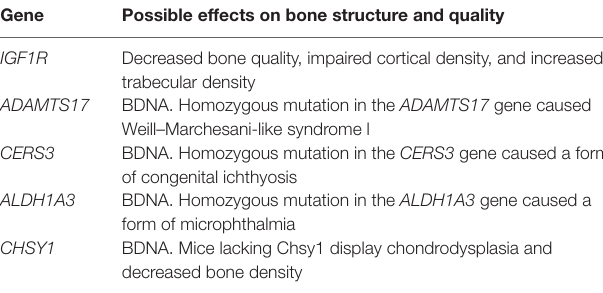
taBLe 1 | Genes involved in the 15q26.2-q26.3 deletion of the patient. Gene possible effects on bone structure and quality